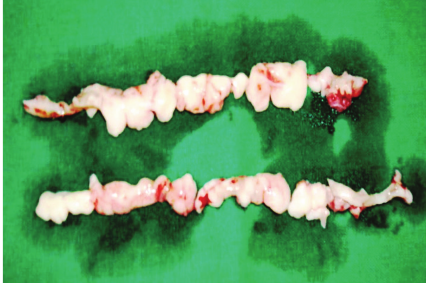
Figure 6: Excised tissue after gingivectomy.